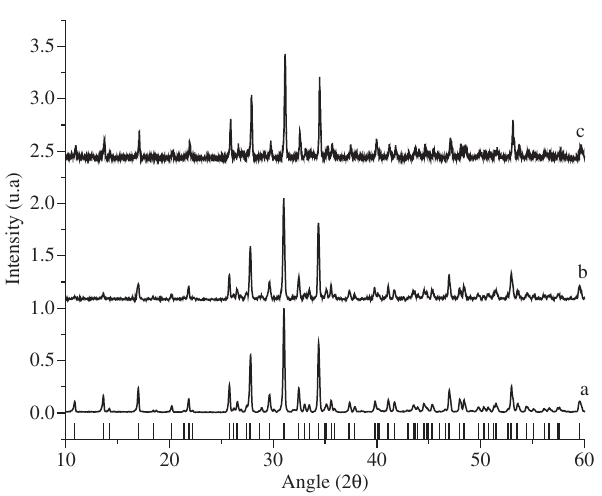
Figure 4. X ray diffractograms of the different specimens: a) starting powder; b) sintered ceramic at 1250 °C/30 min; c) sintered foam at 1250 °C/30 min.